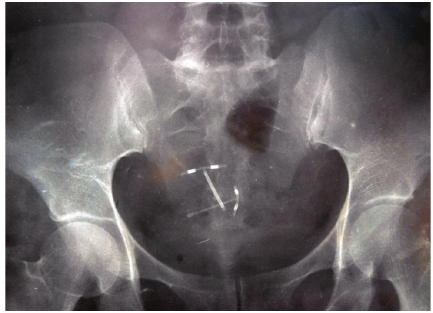
Figure 1: Plain pelvic X-ray showing two copper T-devices.